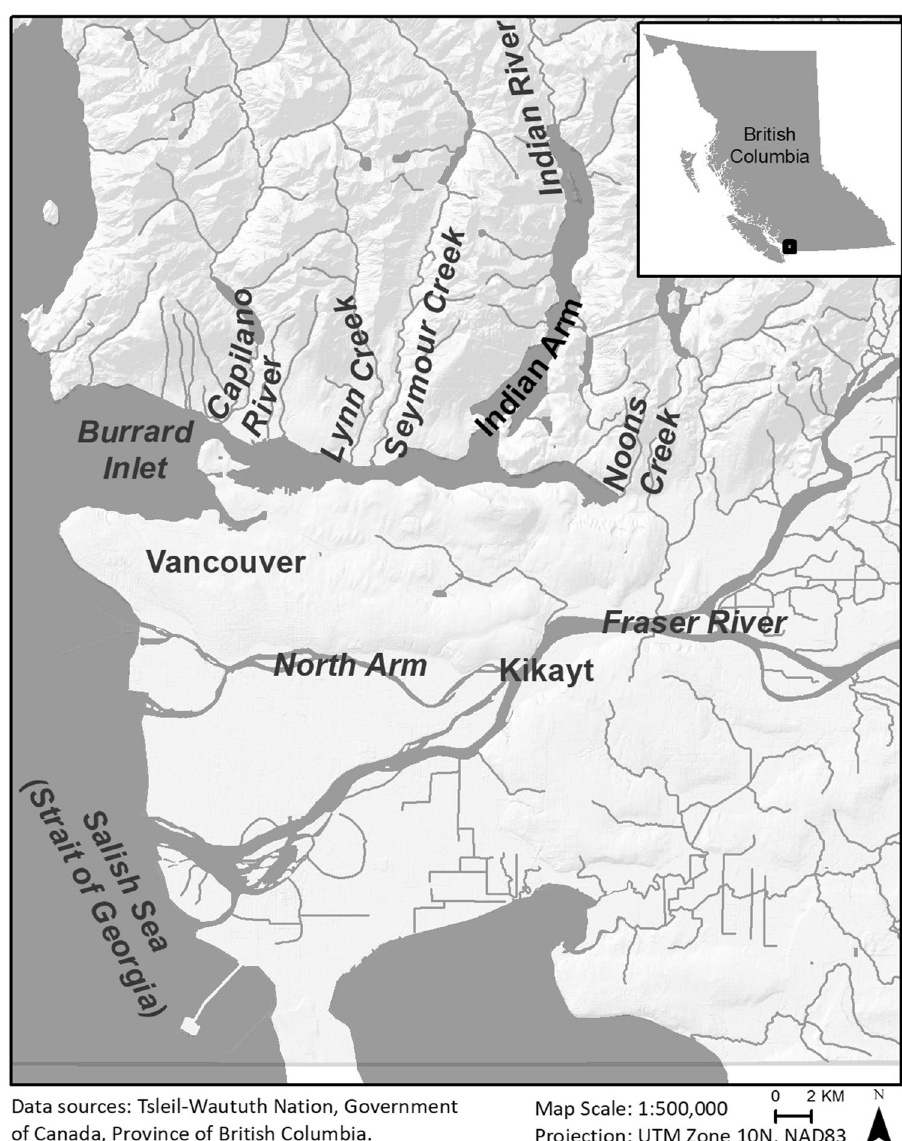
Figure 2. Regional study area and major salmon rivers. Figure created in ESRI ArcGIS version 10.8.1 (https:// www. esri.